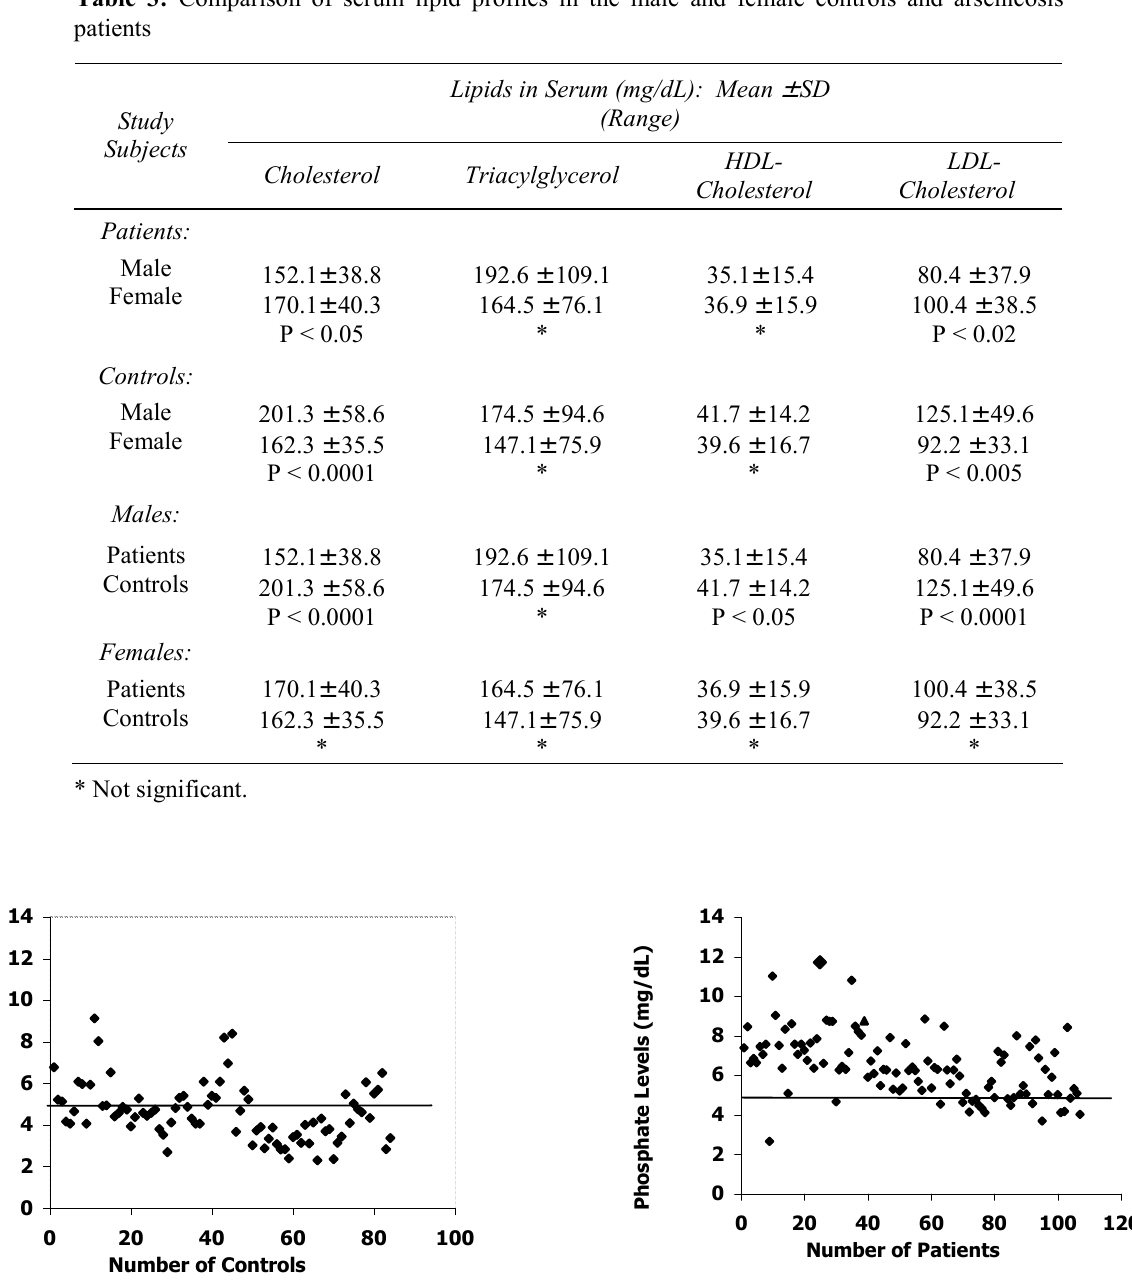
Table 3: Comparison of serum lipid profiles in the male and female controls and arsenicosis